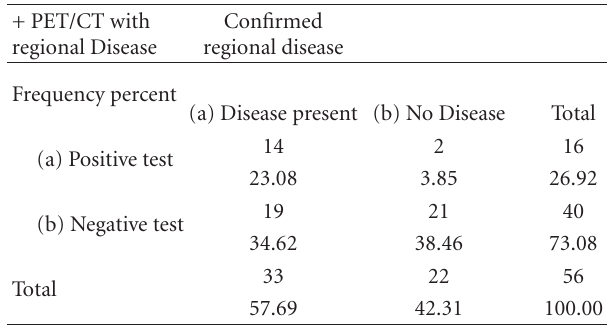
Table 4: 2 × 2 Table of PET/CT with regional metastatic disease. + PET/CT with regional Disease